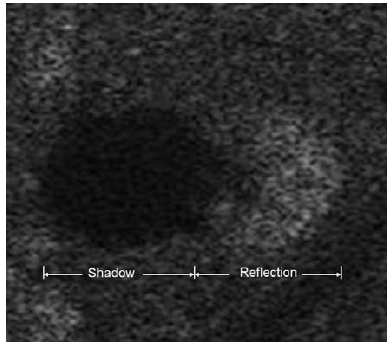
Figure 3. Layover observed of a tree with a rounded canopy in an X-band synthetic aperture radar (SAR) image with 0.5 m pixel resolution. Radar illumination is from the right. The incidence angle is approximately 50°. As in Figure 1, the tree’s radar shadow extends to left, while layover causes the canopy to appear to the right of the base. The arbitrary grayscale extends from black for low backscatter to white for high backscatter.